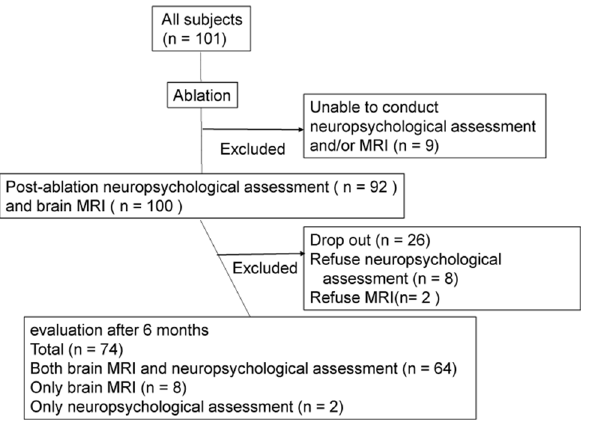
Figure 1. Study protocol. We recruited 101 patients; 9 were excluded because they were unable to conduct neuropsychological assessment and/or brain MRI. Therefore, one hundred patients underwent MRI and 92 underwent neuropsychological assessment at baseline. At 6 months after ablation, 27 patients dropped out, 2 declined to undergo MRI, and 8 declined to perform neuropsychological assessment. Finally, 72 and 66 patients underwent MRI and neuropsychological assessment, respectively. MRI Magnetic resonance imaging.